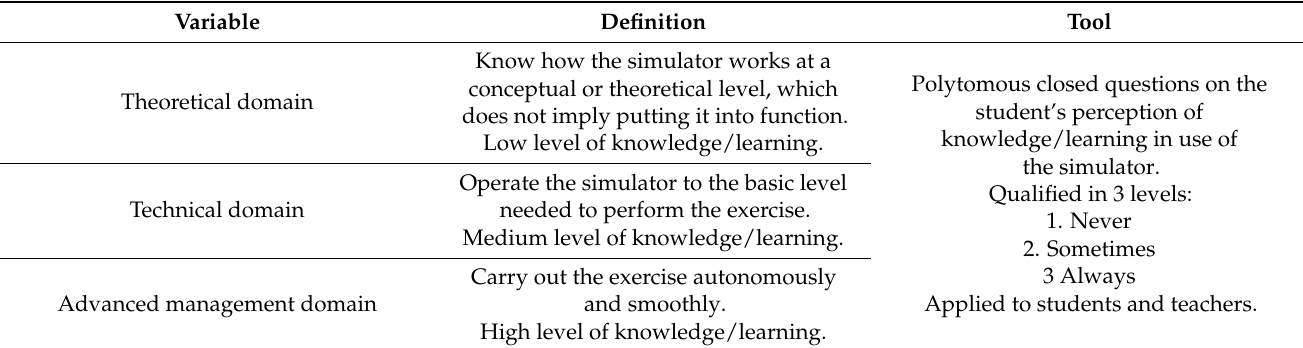
Table 1. Description of dependent variables.